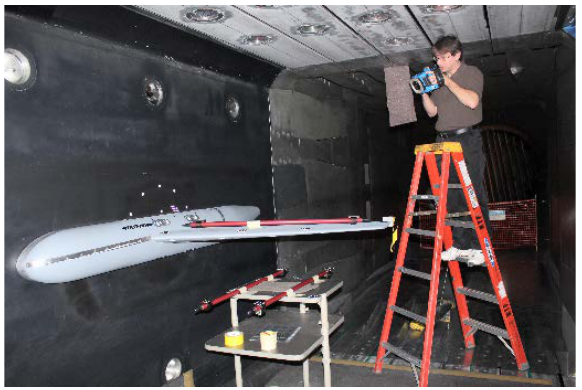
Figure 2. Test section set-up for the FastMac semi-span model in the NTF wind